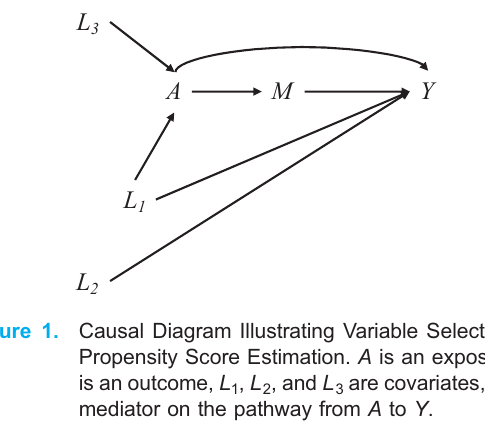
Figure 1. Causal Diagram Illustrating Variable Selection for Propensity Score Estimation. A is an exposure, Y is an outcome, L 1 , L 2 , and L 3 are covariates, M is a mediator on the pathway from A to Y